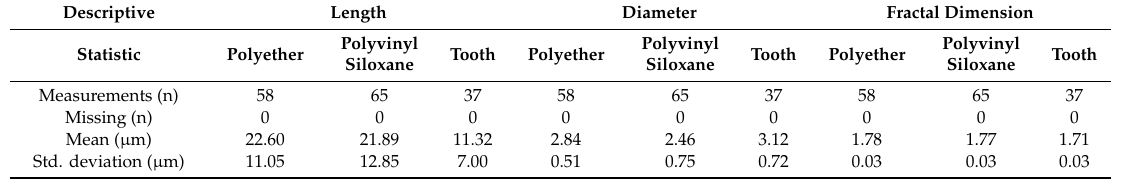
Figure 2. Representative scanning electron microscopy images ( a – c ) and corresponding binarized images ( a1 – c1 ) for calculation of the fractal dimension ( D f ). ( a , a1 ) Tooth surface. ( b , b1 ) Polyvinyl siloxane impression material surface and impression tags as indicated by the black arrows. ( c , c1 ) Polyether impression material surface and impression tags. Arrows indicate impression materials; Asterisks show examples of the impression of dentinal tubules. Table 1. Descriptive statistics of the Euclidean and fractal dimension analyses.